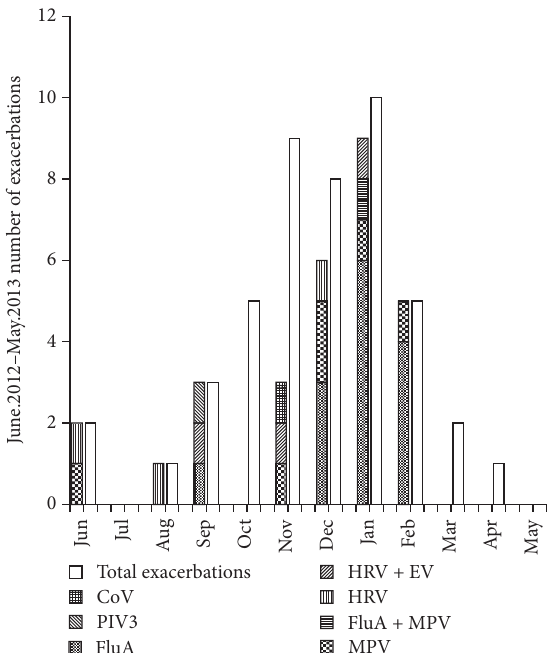
Figure 2: Monthly distribution of viruses detected by multiplex PCR and RT-PCR in AECOPD. FluA: influenza A, MPV: human